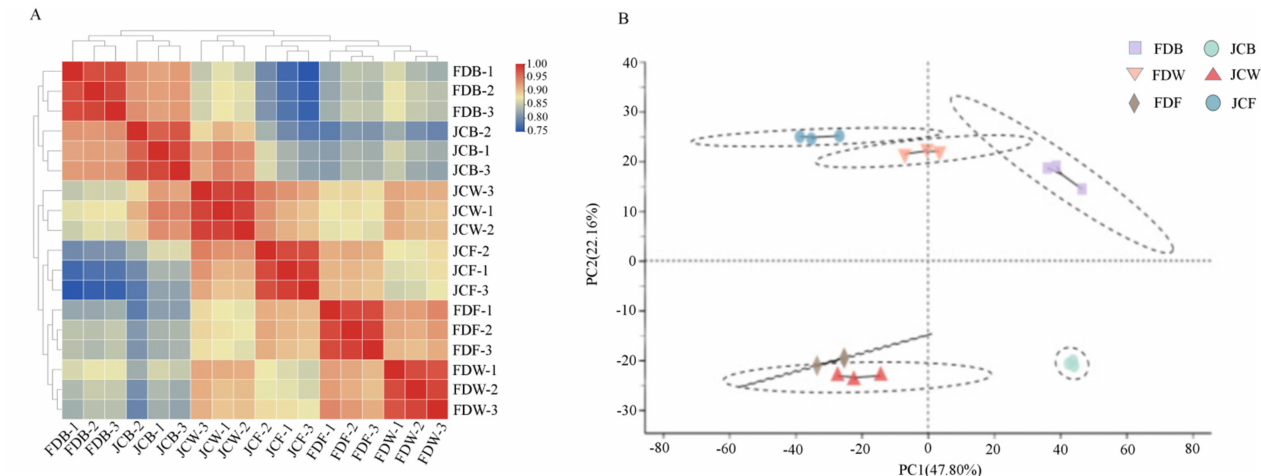
Figure 2. Pair-wise Pearson correlation coefficients of the sequencing data from three replicates × two genotypes in three periods ( A ). Principal component analysis (PCA) of transcriptome data ( B ).